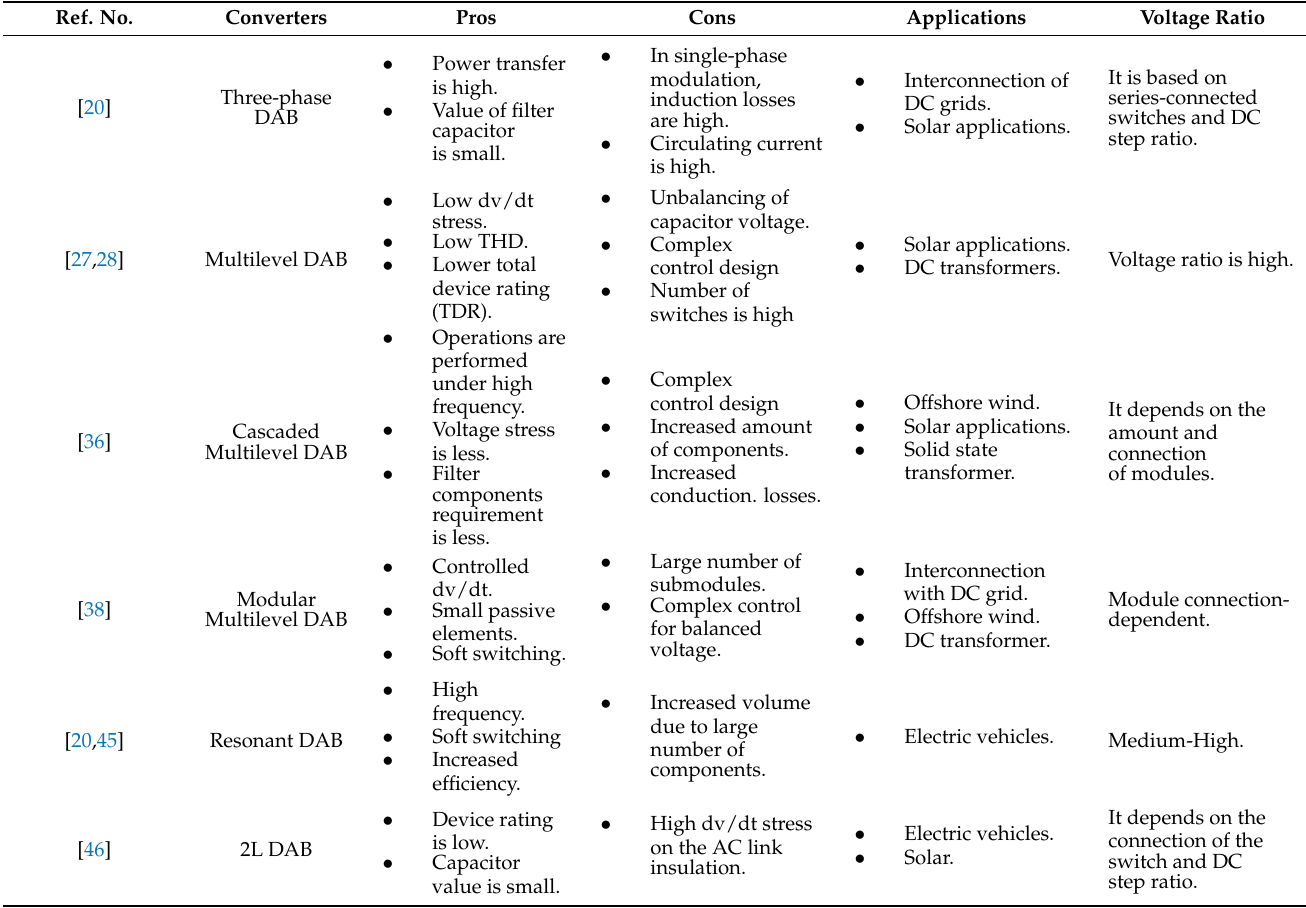
Table 2. Characteristics of DAB converters